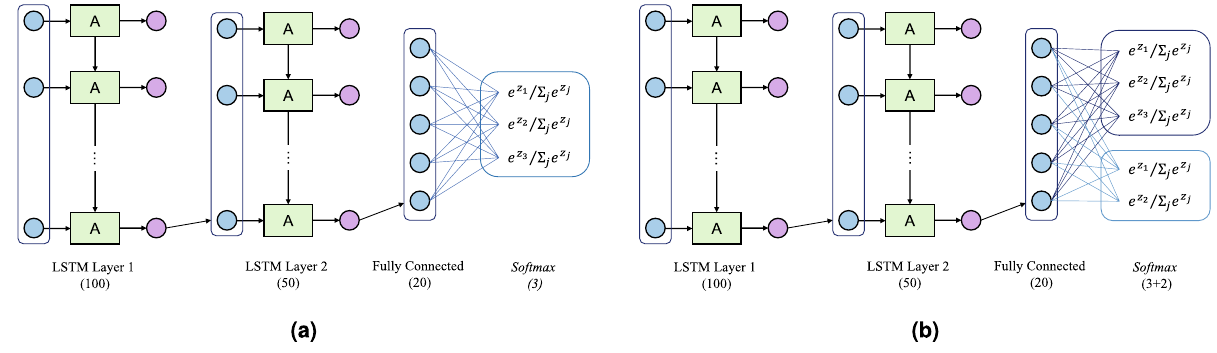
Figure 2. Network architecture featuring LSTM and fully-connected layers: (a) payload estimation and (b) multi-output network for HAR.